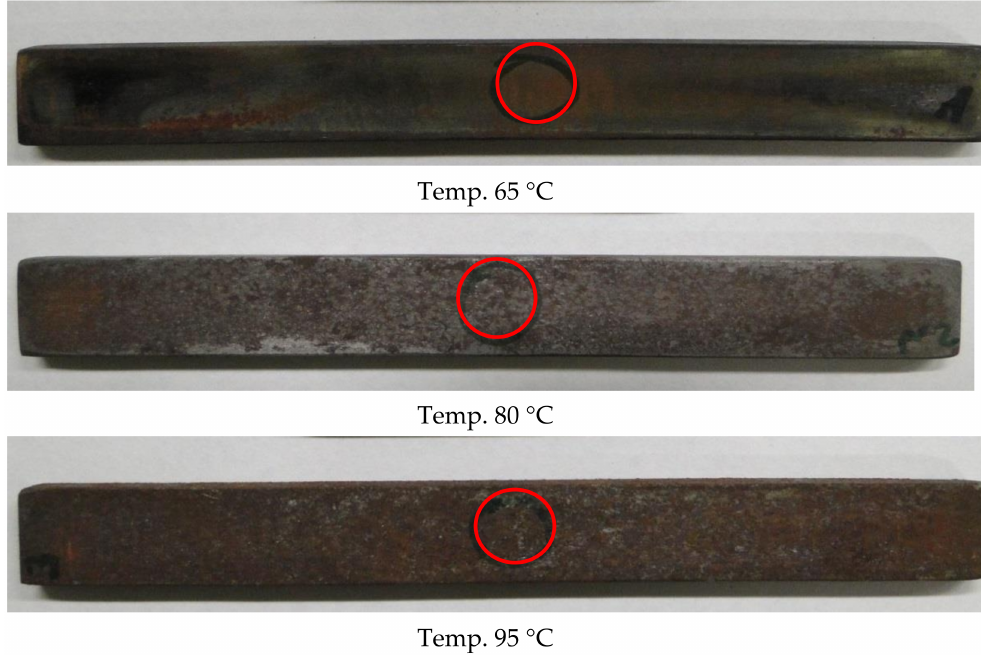
Figure 3. View of a coupon for research with selected places observed by SEM and EDS microanalysis.